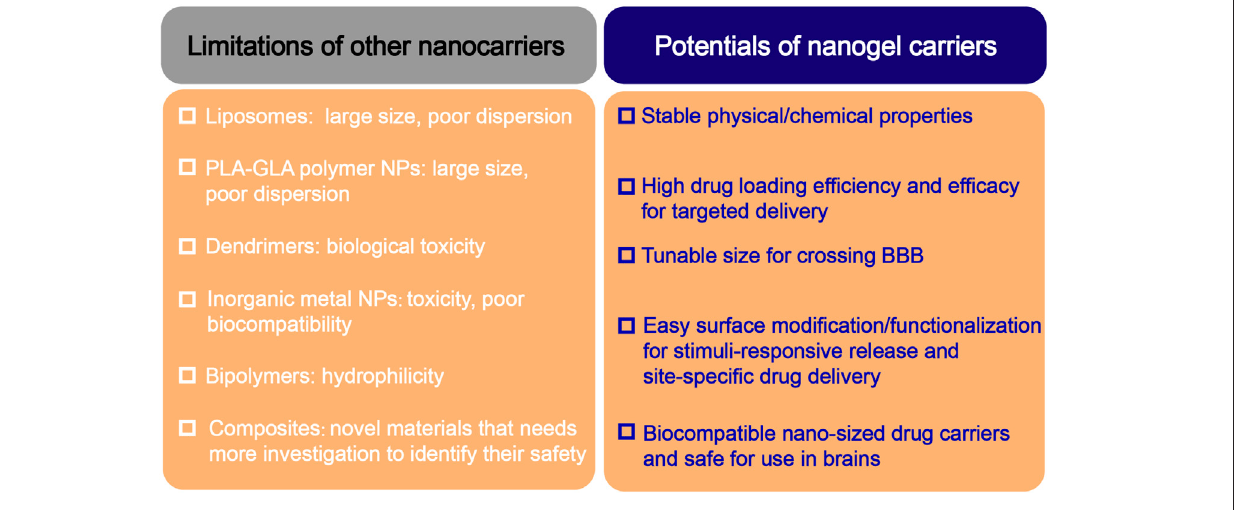
Frontiers in Bioengineering and Biotechnology |